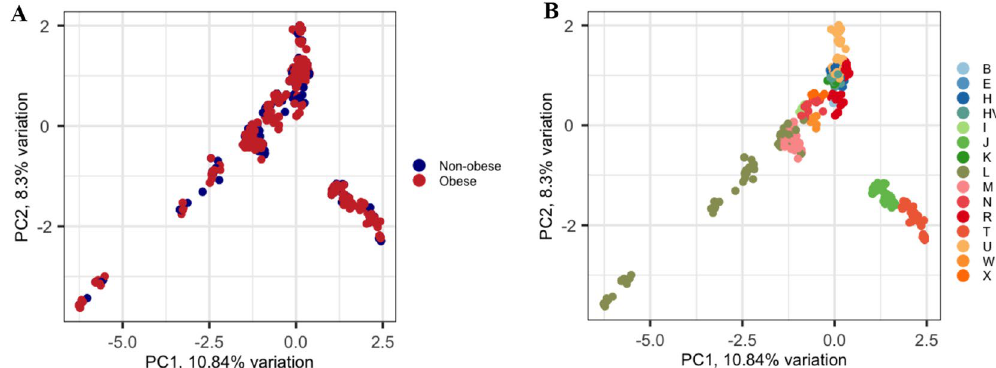
Figure 3. Principal component analysis of the 864 Qatari samples based on their mtDNA. ( A ) Obesity status was considered: the blue color represents the non-obese individuals and the red color represents the obese individuals. ( B ) Haplogroup profiling was considered. PC1 and PC2 on x- and y-axis represent Principal component 1 and Principal component 2 and their variations in percentage, respectively.